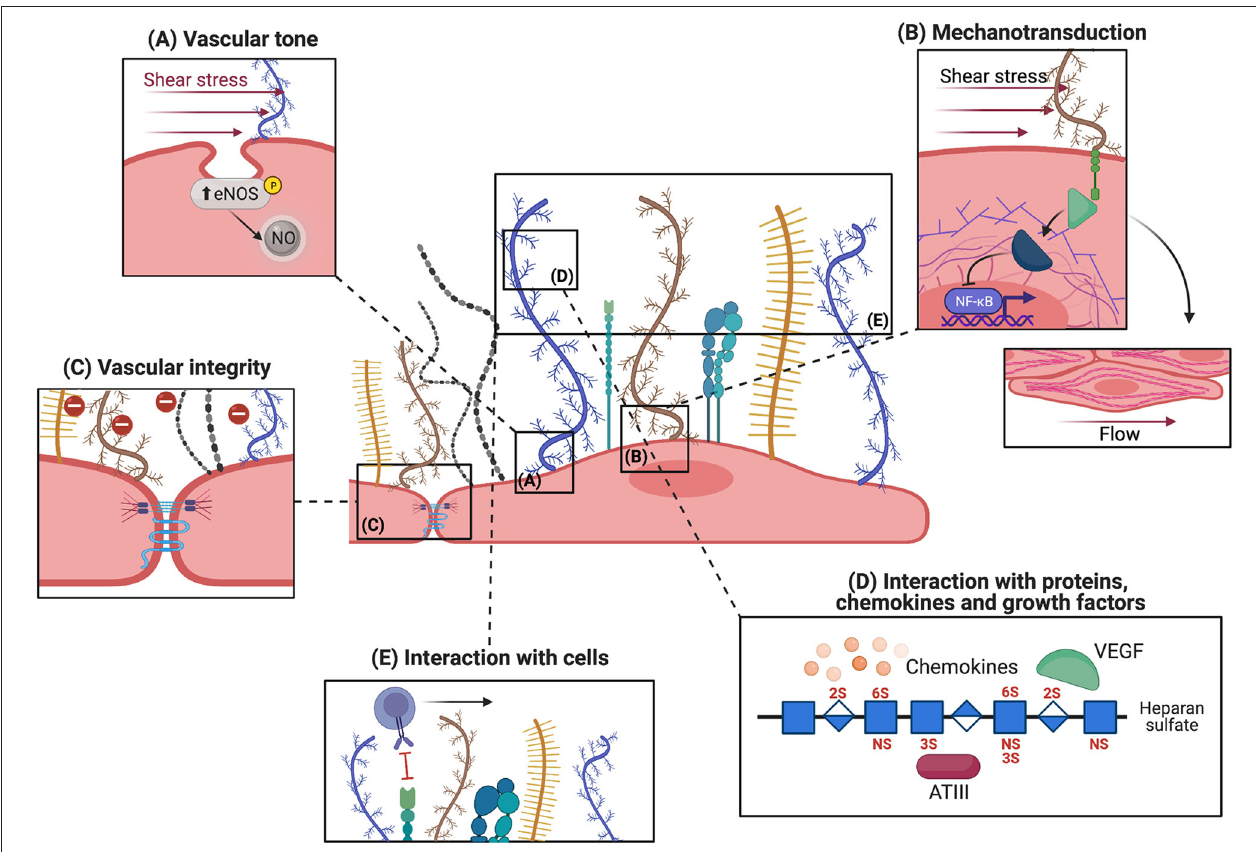
FIGURE 2 | Physiological functions of the endothelial glycocalyx. The microvascular glycocalyx fulfills both mechanical and biochemical functions under physiological conditions, the five main functions are depicted here. (A) Sensing and transmission of shear stress by syndecans (shown in blue), located near membrane caveolae, increases eNOS activity and NO release. This assures vasodilatory functions. (B) Transmission of shear stress to the cytoskeleton via the cytoplasmic linker region (green) of syndecans leads to rearrangement of actin filaments and cell alignment in the direction of flow. Mechanotransduction also activates intracellular signaling molecules like Rho GTPases which regulate NF K B and MAPK. (C) The glycocalyx acts as a charge- and size-selective barrier to proteins. HS is important for maintaining intact junctions and vascular integrity. (D) Different molecules can bind to glycocalyx components: regulatory plasma proteins whose activity is potentiated by interaction with the glycocalyx, chemokines which are locally concentrated, and growth factors. (E) The intact glycocalyx shields off selectins and integrins expressed on EC thereby inhibiting leukocyte